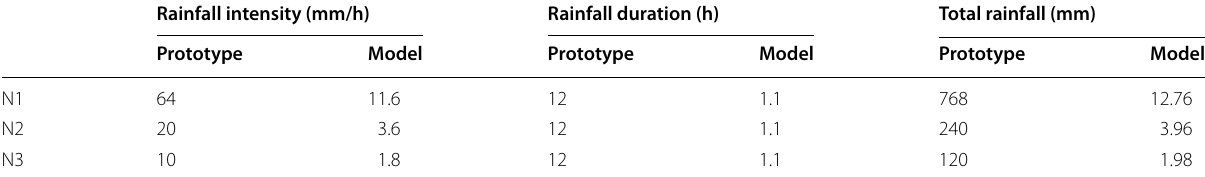
Table 3 Model rainfall program